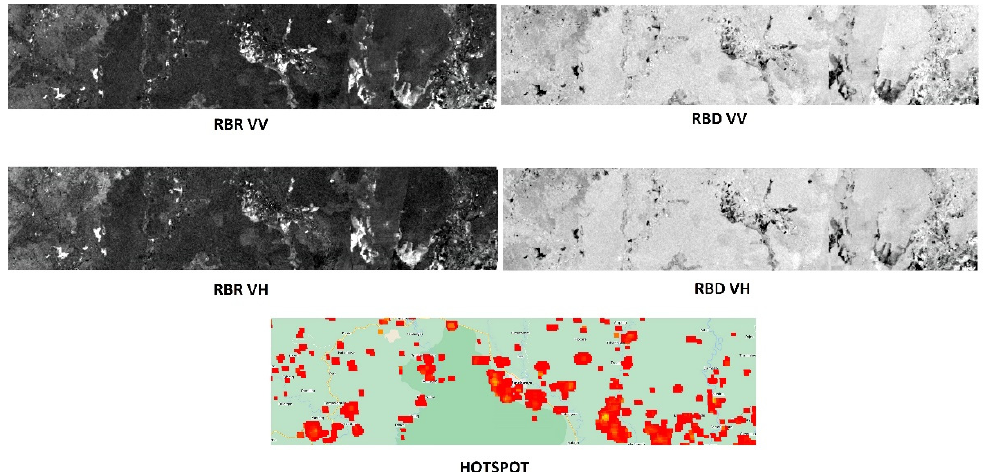
Figure 4. Sample of the cross-polarized and co-polarized image and its difference from the Sentinel-1a SAR images with the actual Hotspot